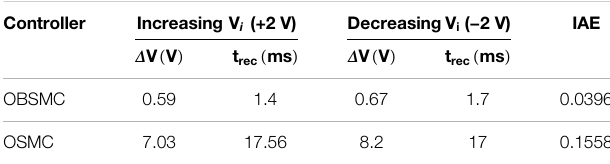
TABLE 3 | Performance speci fi cation of the converter related to input voltage variations